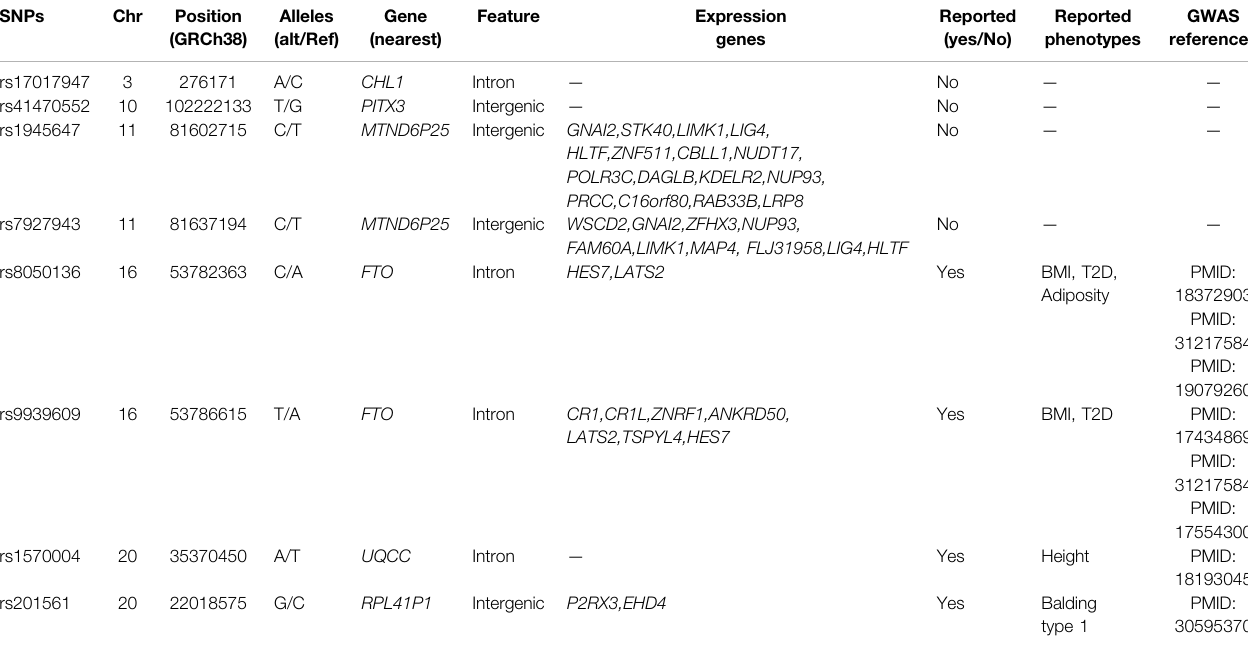
TABLE 5 | The annotations of the signi fi cant identi fi ed SNPs.